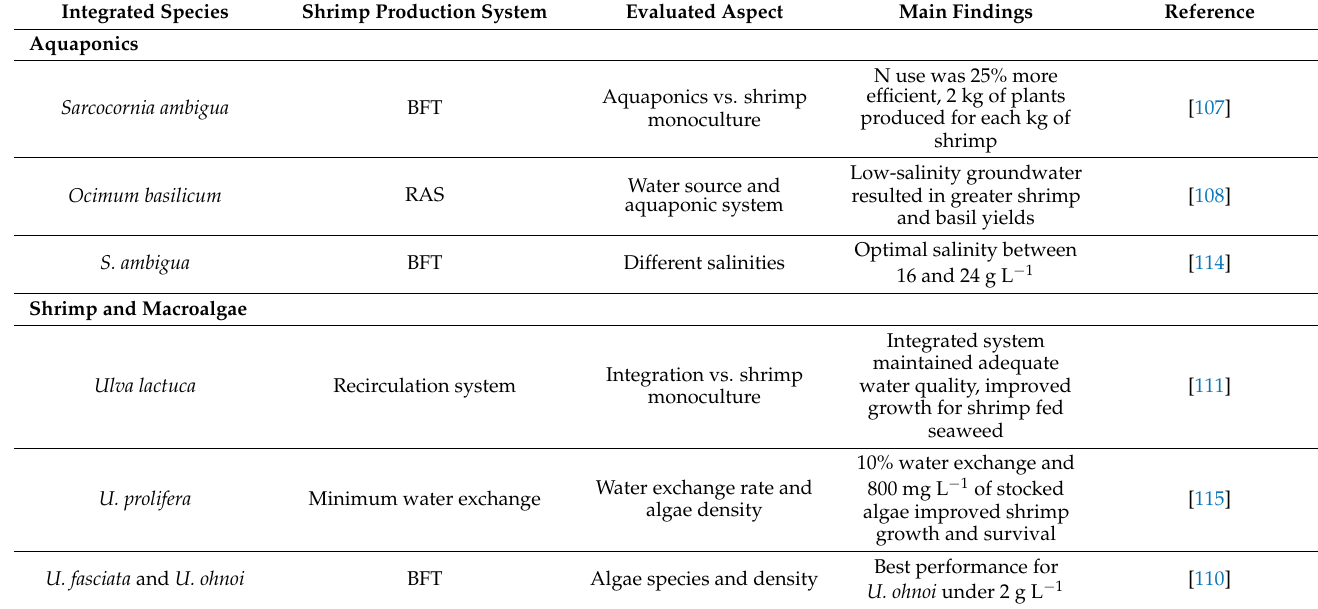
Table 4. Summary of recent studies evaluating different aspects of L. vannamei -based integrated rearing